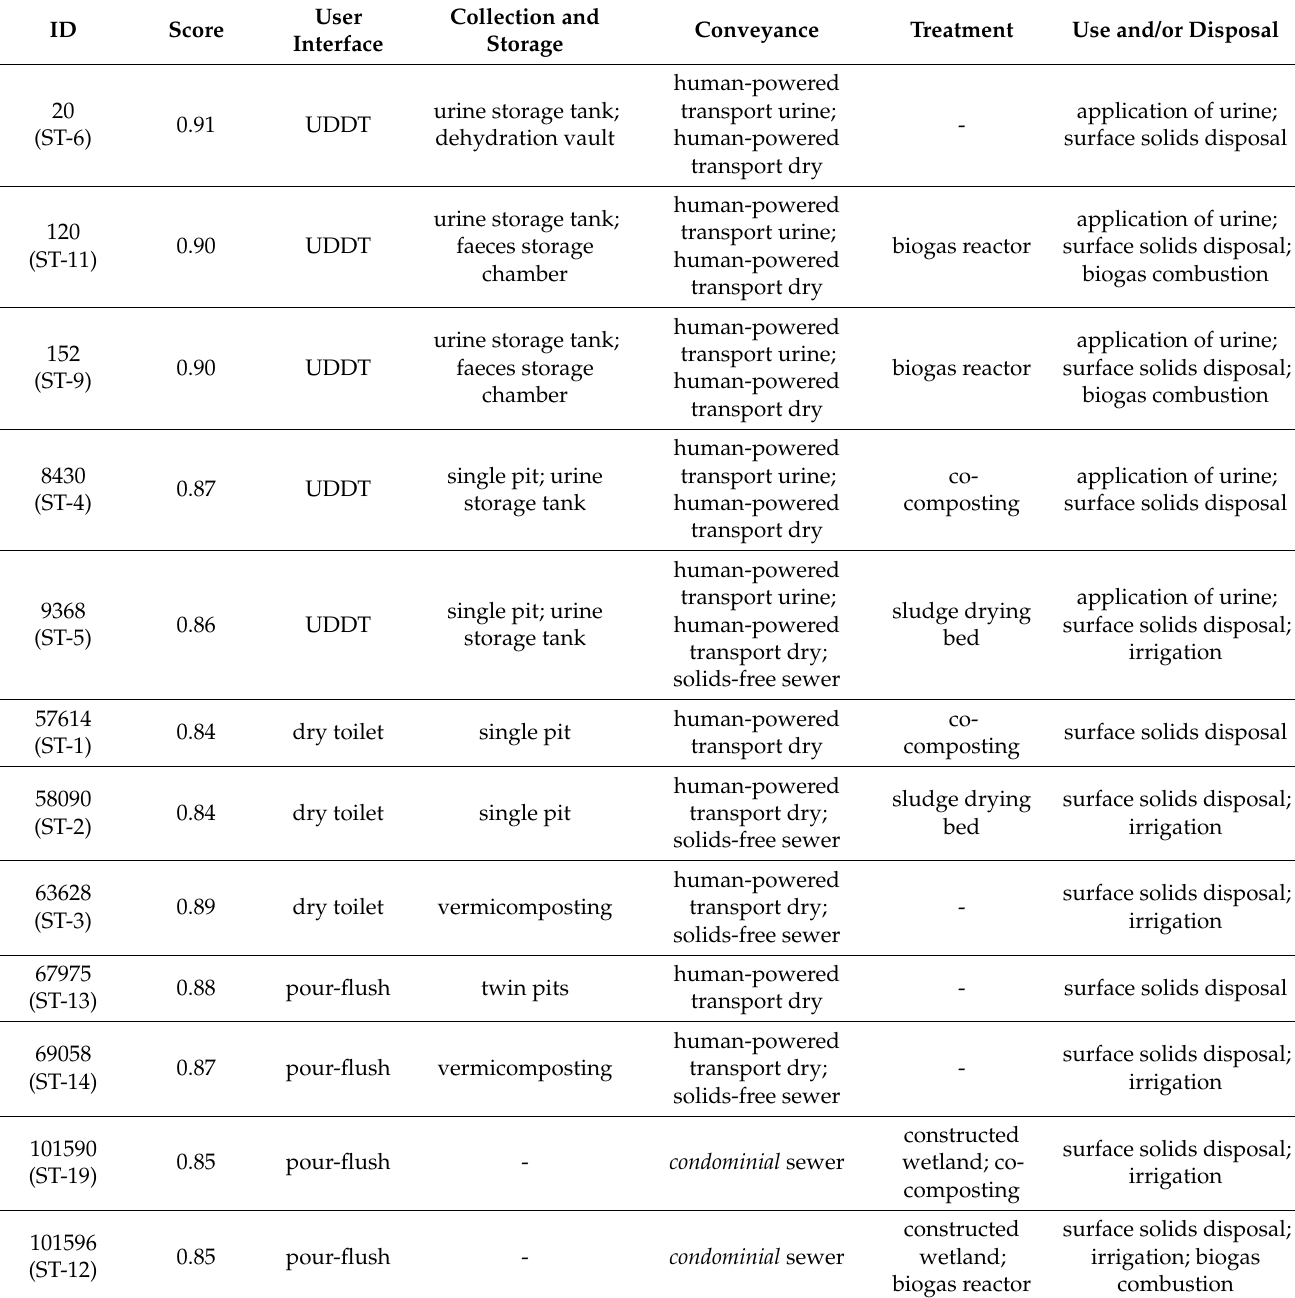
Table 3. List of technologies of the selected sanitation systems grouped by its functional